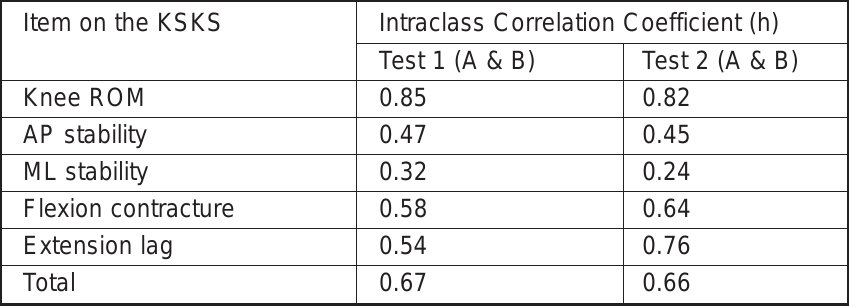
Table 3: The Intraclass Correlation Coefficient of inter rater reliability for the individual scores during test 1 and test 2, between Examiners A and